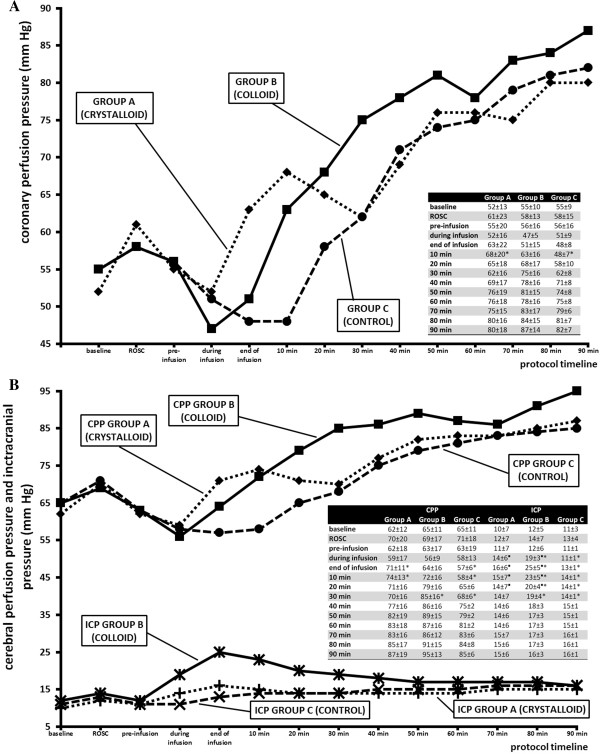
Values of coronary perfusion pressure (CoPP), cerebral perfusion pressure (CPP) and intracranial pressure (ICP) during the protocol. (A) CoPP values. (B) CPP and ICP values. Asteriks indicate significant differences between group C and group A and/or B. Solid line, group A; dotted line, group B; dashed line, group C. Solid square symbols indicate significant differences between group A and group B. ROSC, return of spontaneous circulation.